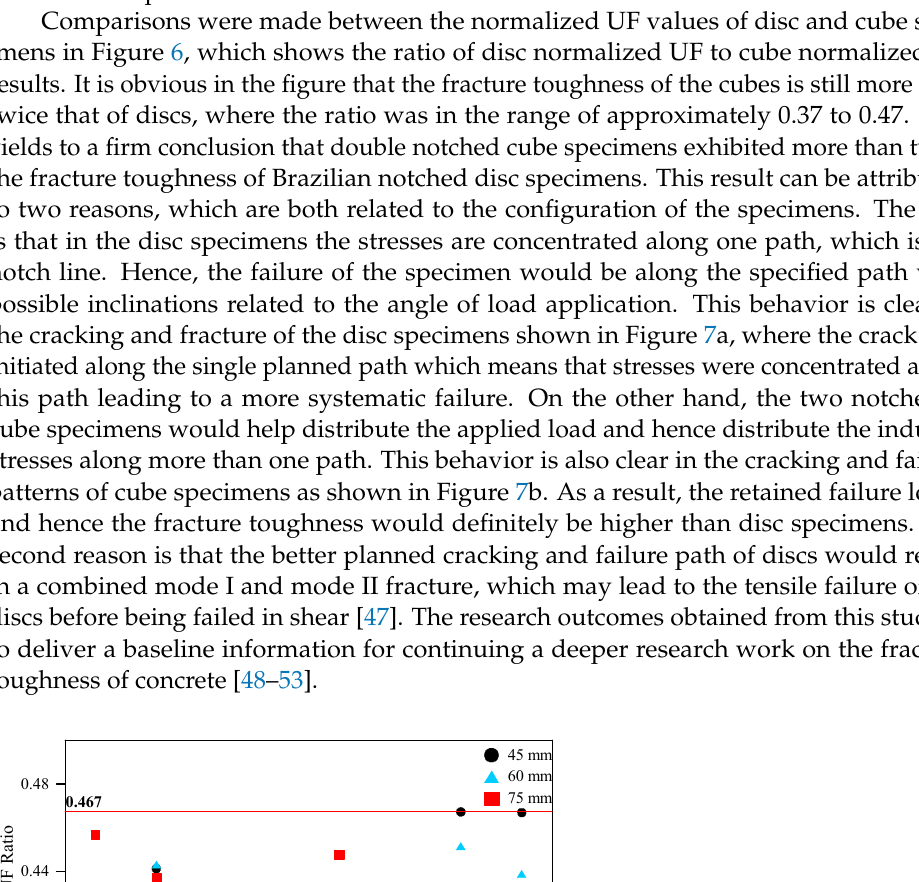
Figure 5. Mode II cube specimens’ fracture energy for different notch depth-specimen width (a/W) ratios.